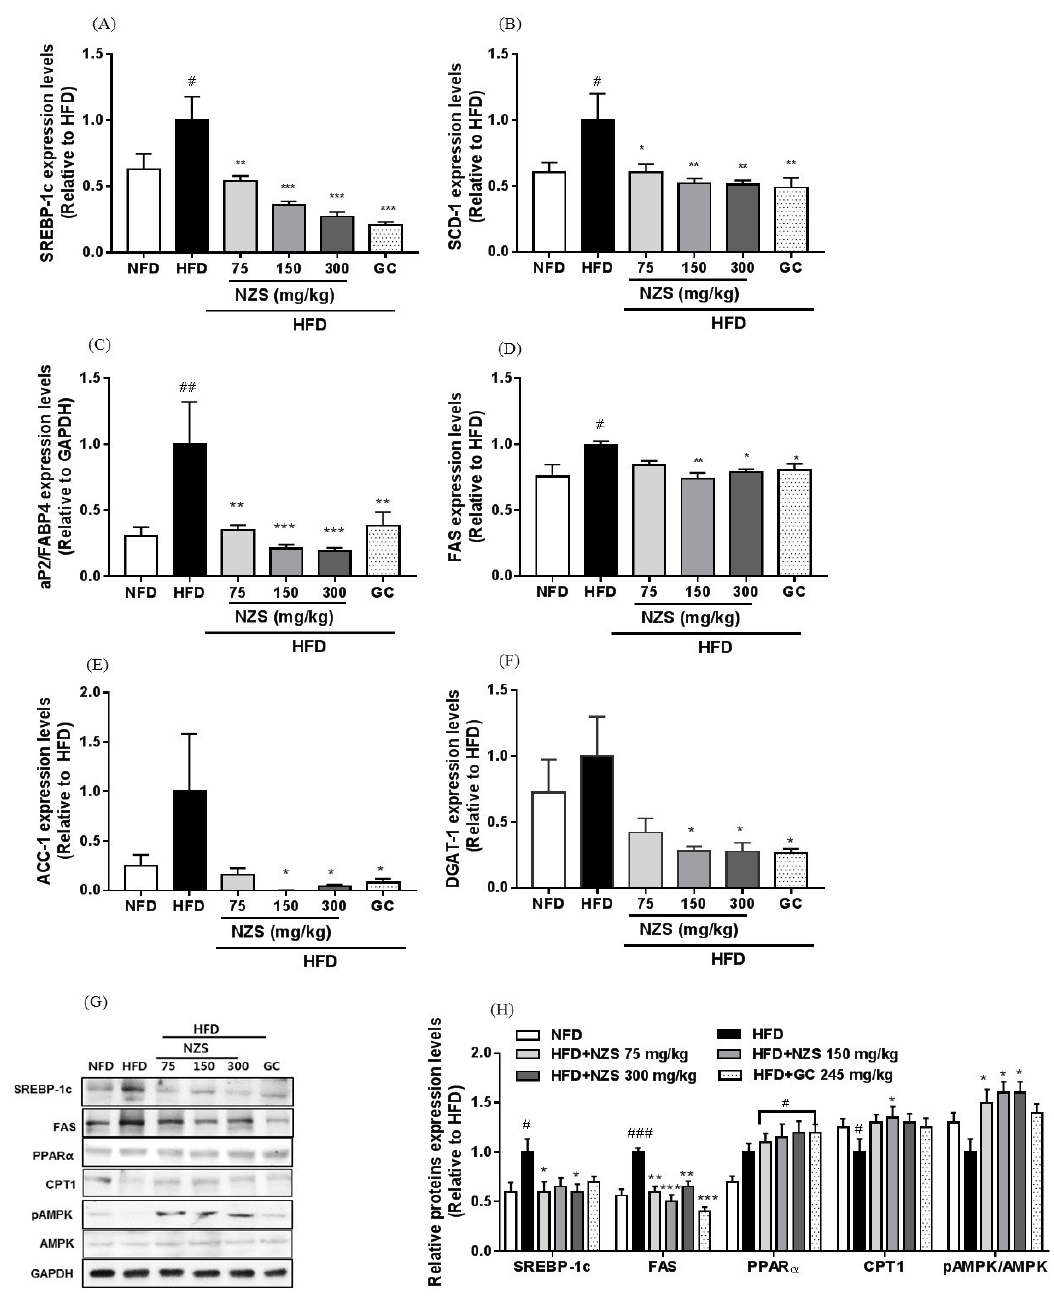
Figure 7. Effects of NZS on the expression levels of lipid-metabolism-related genes and proteins in the liver. mRNA expression levels of ( A ) SREBP-1c, ( B ) SCD-1, ( C ) aP2/FABP4, ( D ) FAS, ( E ) ACC-1, ( F ) DGAT-1, ( G ) representative protein expression, and ( H ) densitometric analyses of protein expression levels. NFD: normal-fat diet; HFD: high-fat diet; NZS: Tetragonia tetragonoides (Pall.) Kuntze extract (New Zealand spinach); GC: Garcinia cambogia extract. Values are expressed as mean ± SEM ( n = 5). # p < 0.05, ## p <